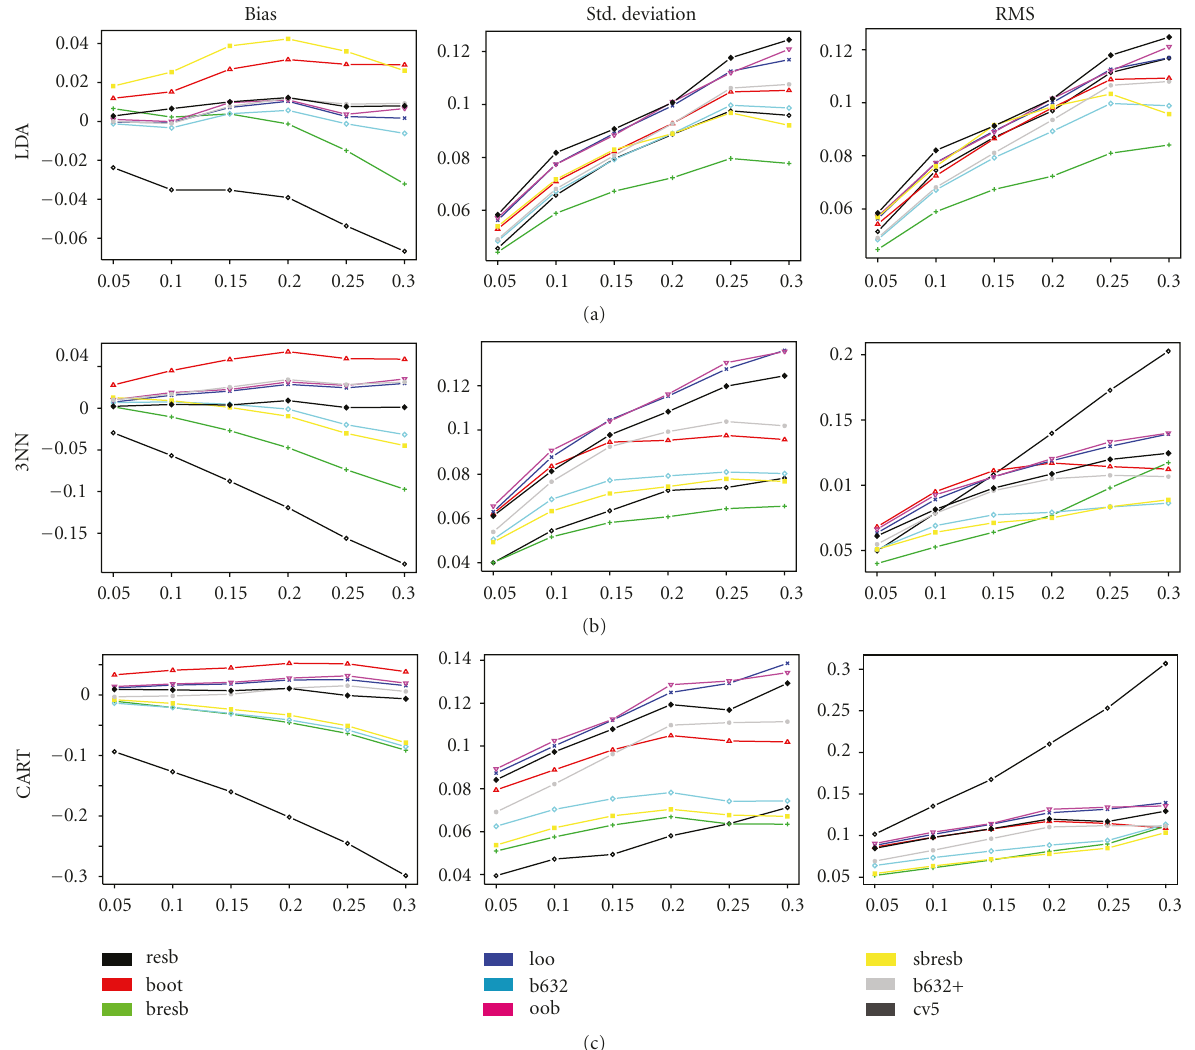
Figure 2: Bias, variance (standard deviation), and RMS of as a function of the Bayes error, for the synthetic data, sample size n = 20, and dimensionality p = 2, with di ff erent base classification